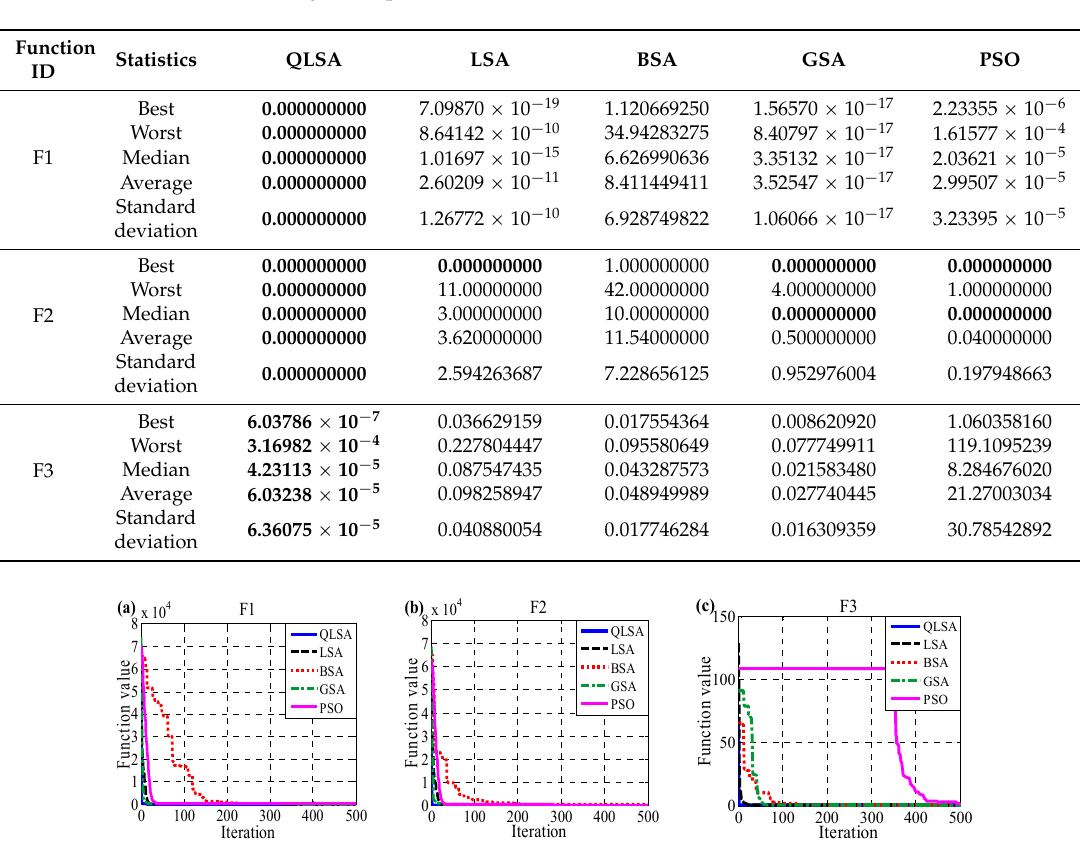
Table 4. Test 1 global optimization results for benchmark functions in Table 3.